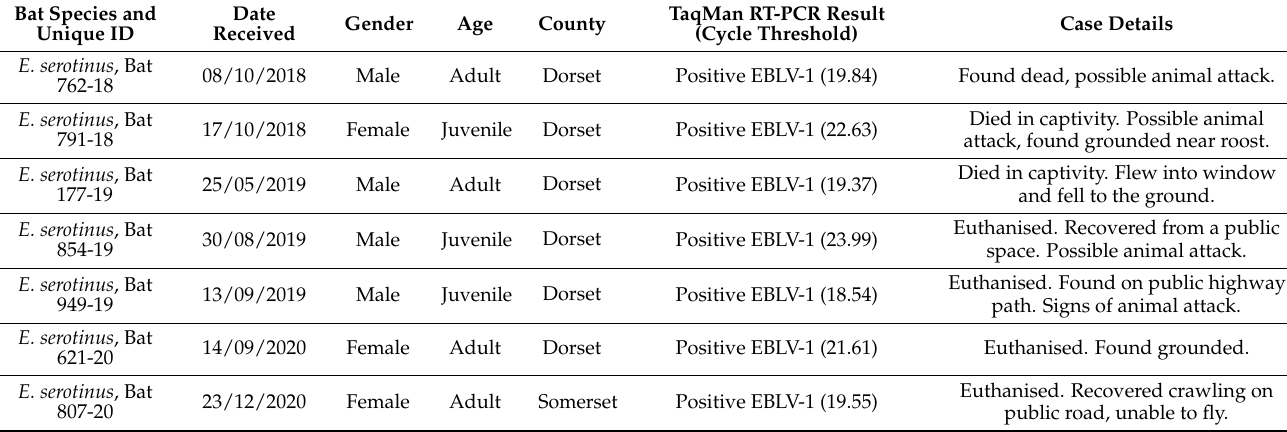
Table 1. Description, TaqMan RT-PCR result, and case details for seven EBLV-1 positive serotine bats ( E. serotinus ) recovered in the UK between 2018 and